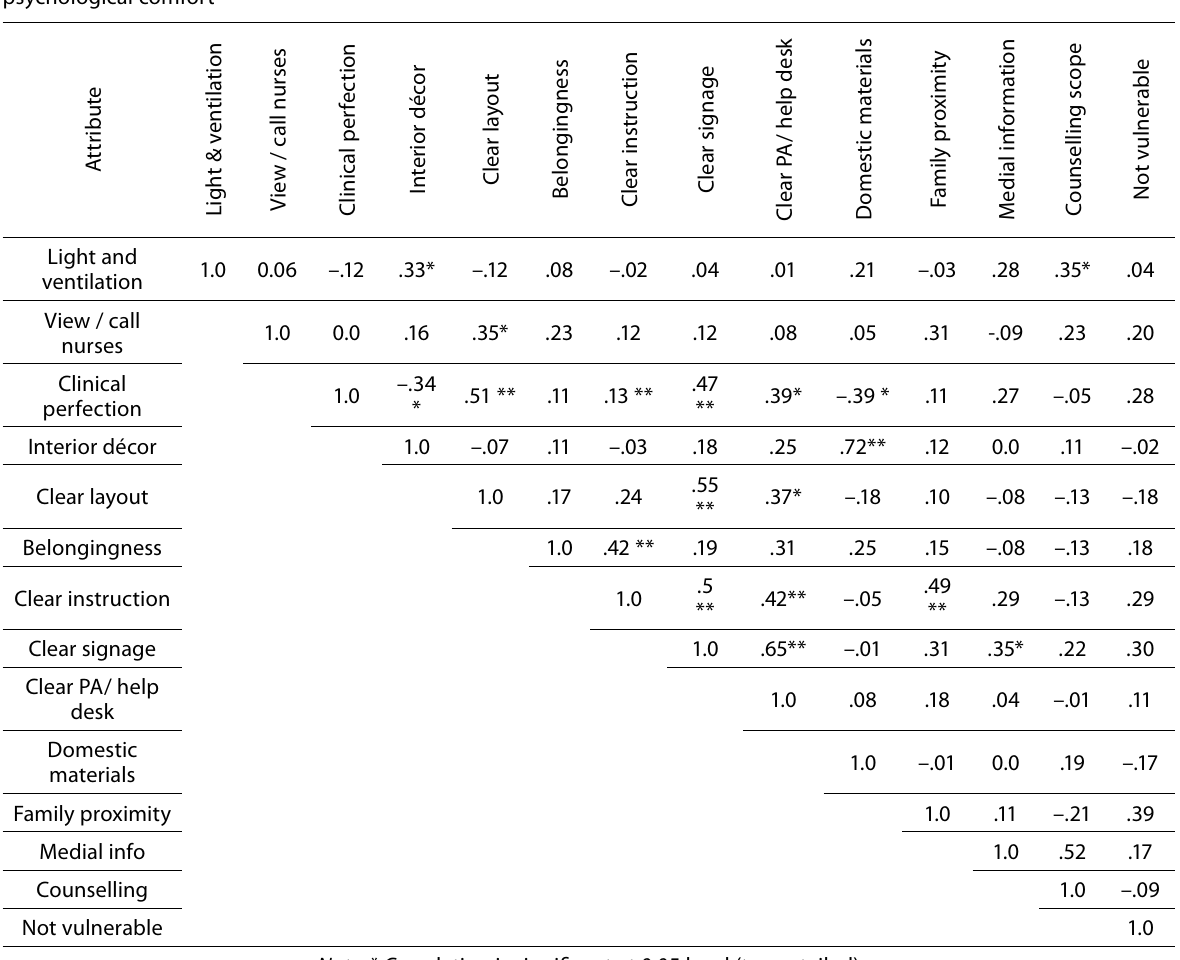
Table 3. Correlation Coefficient for the average values of effectiveness of the environmental attributes in ensuring psychological